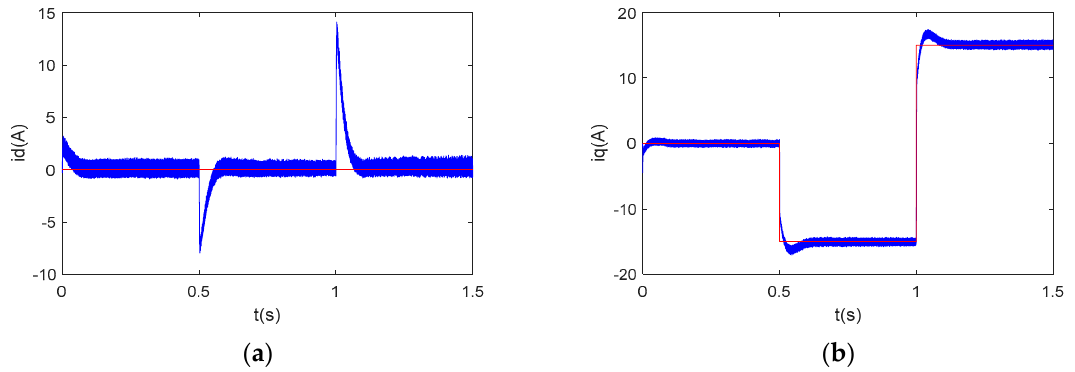
Figure 5. d-q axis current waveform of the conventional current controller without decoupling at 6000 rpm. ( a ) d-axis current; ( b ) q-axis current.